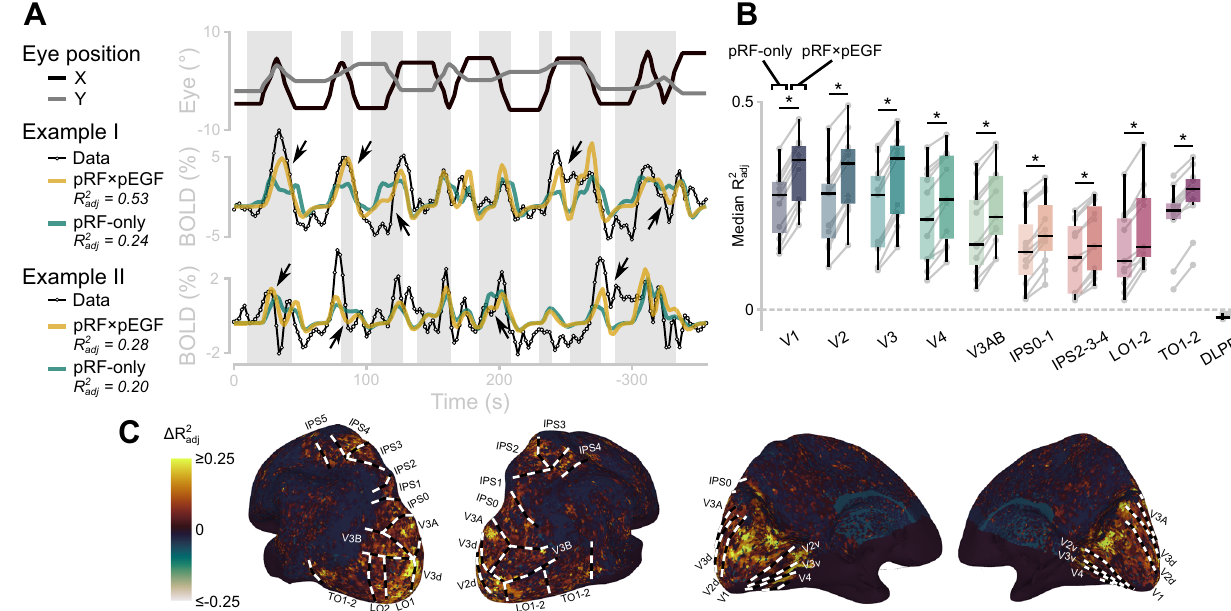
Fig. 3 | Population eye-position dependent gain fi elds (pEGF) improve pre- dicted BOLD signal time series based on population receptive fi elds (pRF). A Two exampleBOLDtime seriesfromV1. Eye position time series (top black, gray lines)and bardisplays (gray rectangles) of version A of the eye-movement task are plotted for reference. Example I, voxel for which the pRF-only prediction (green) markedlyimprovedwhenthepEGFwasaddedtothepRF(yellow).Arrowsindicate parts of the time serieswhere the predictionwasmost notablyimproved.Example II,voxelthatisrepresentativeofthemedianadjustedR 2 inV1,bothforthepRF-only and the pRF×pEGF models. B Change in adjusted R 2 per visual ROI. Per ROI, the light, left boxplot represents the pRF-only model, the right, dark boxplot repre- sents the pRF×pEGF model. Gray lines and points represent single participants ( N =11).Intheboxplot,thecenteristhemedian,theboxboundsareQ1andQ3,the